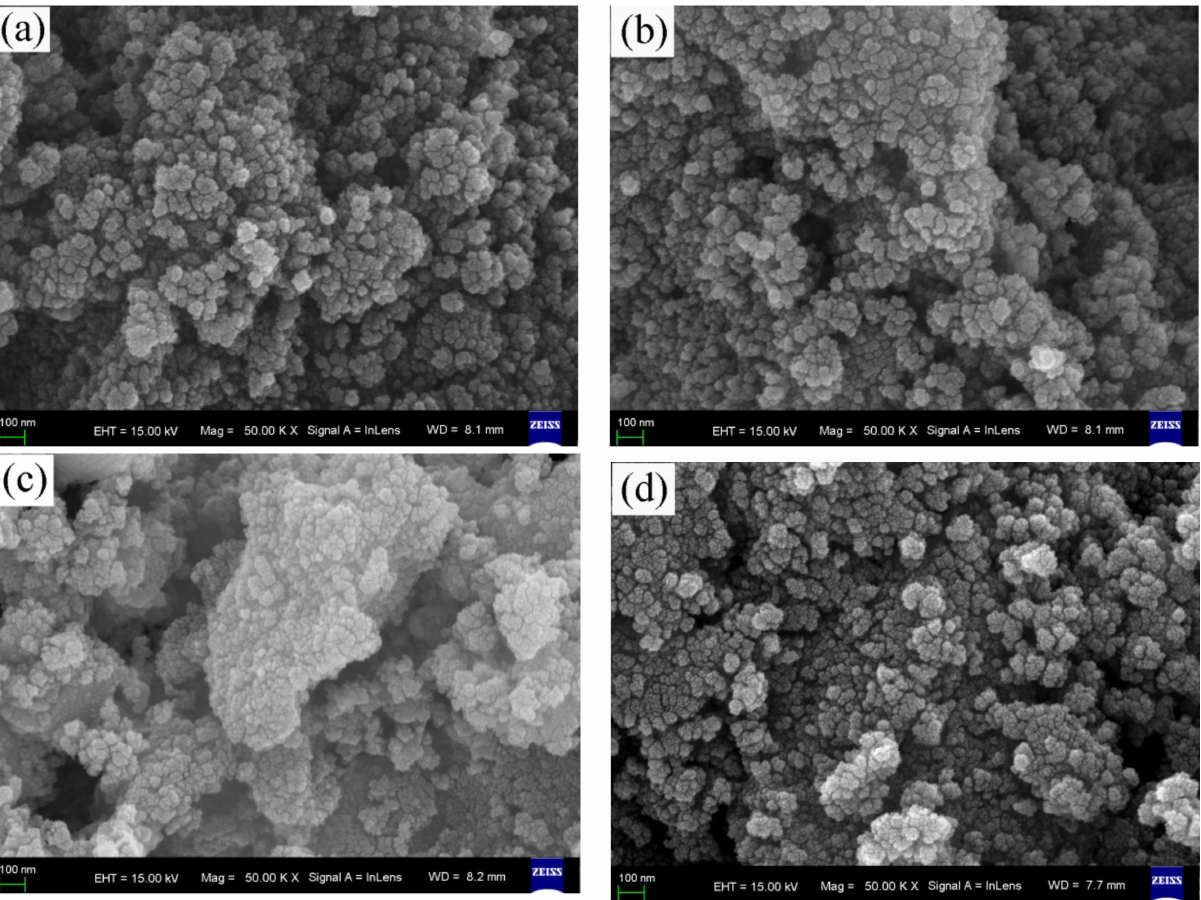
Figure 1. Field emission scanning electron microscopy (FESEM) images of ( a ) pure, ( b ) wool keratin modified, ( c ) KH550 modified, and ( d ) chitosan modified Fe 3 O 4